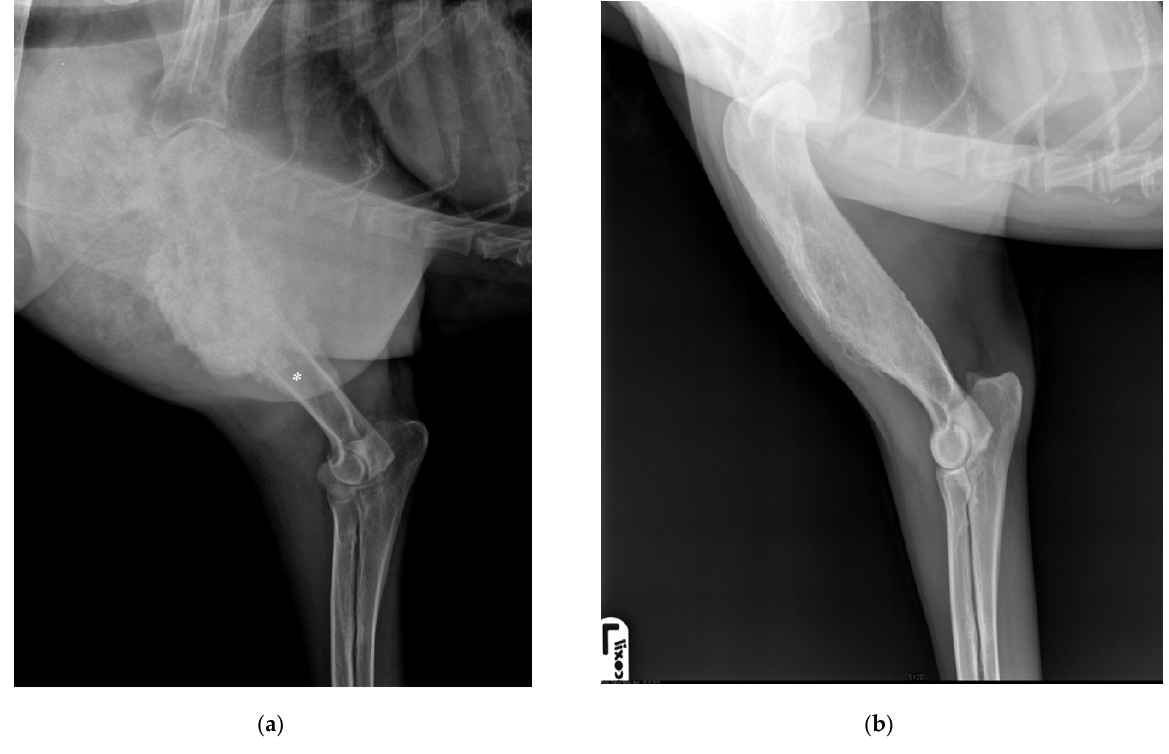
Figure 3. ( a ) Lateral view of right humerus, six years after the first admission, shows a heterogeneous lesion in the proximal right humeral diaphysis characterized by a mixture of lysis and focal sclerosis, and an active, irregular periosteal reaction and the indistinct transition zone proximally between normal and abnormal bone (asterisk). ( b ) Lateral view of left humerus, six years after the first admission, shows a residual periosteal reaction at the humeral diaphysis.